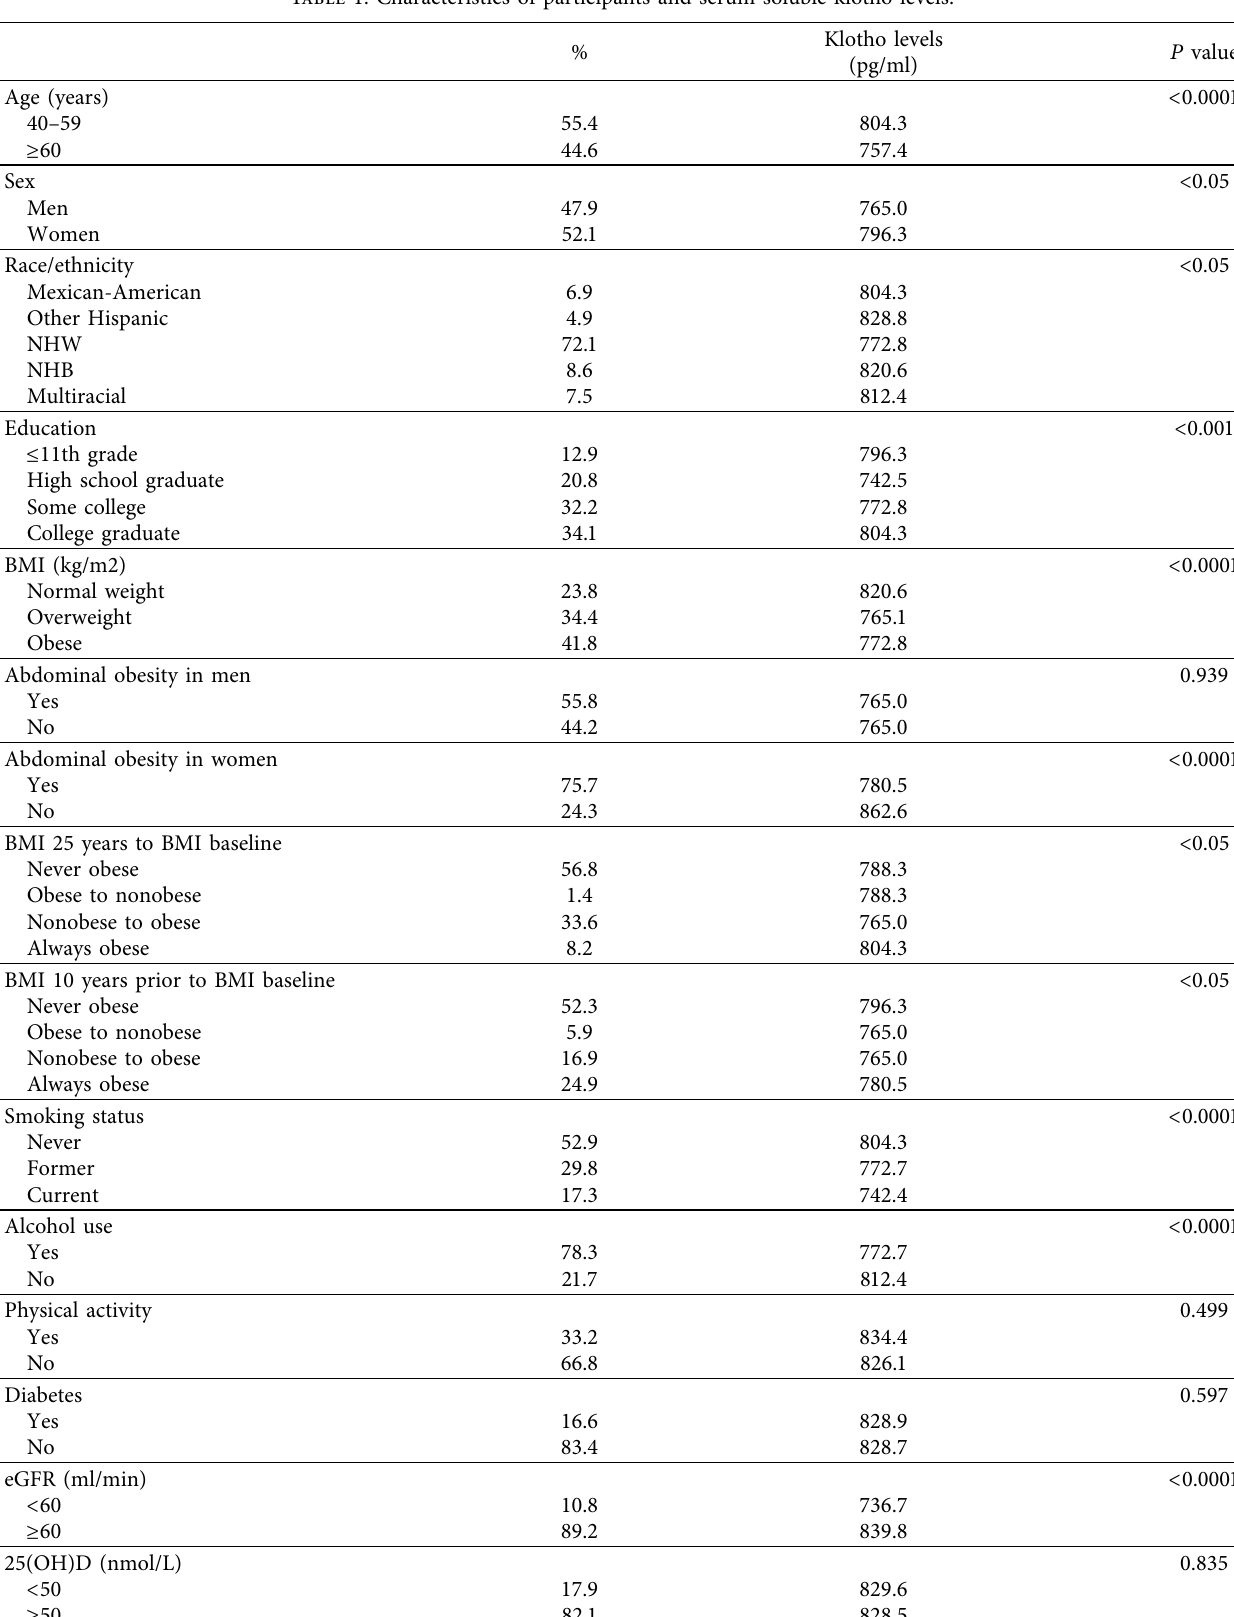
Table 1: Characteristics of participants and serum soluble klotho